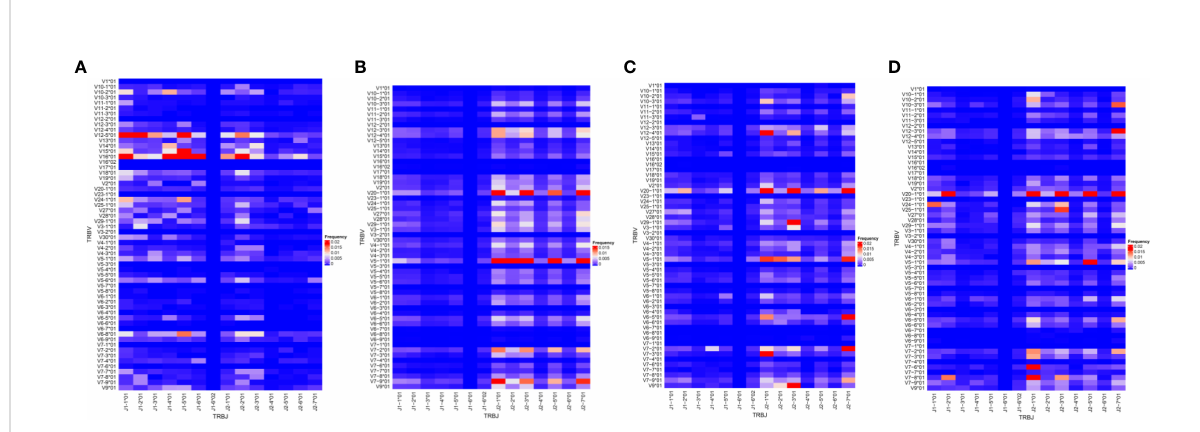
FIGURE 3 Frequency of V and J gene pairing. The VJ repertoire in each group (A) control (n=4); (B) asymptomatic (n=7); (C) uncomplicated (n=9); (D) severe malaria (n=8) group were plotted. The X and Y axes list all possible V and J gene combinations displaying the frequency of usage; with red being the highest frequency, blue representing the lowest